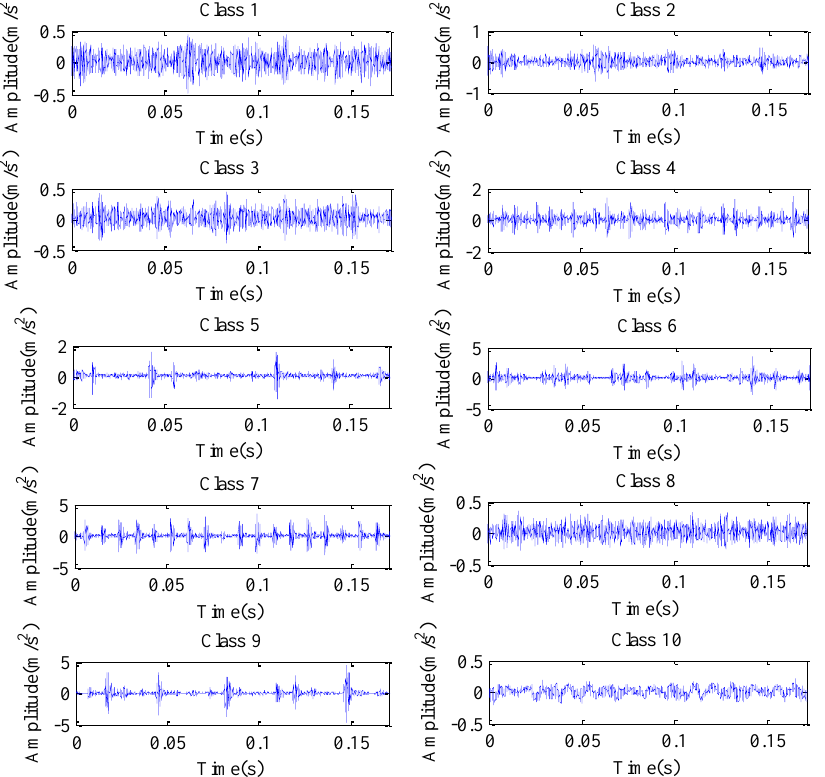
Figure 3. One vibration signal sample for each of the ten bearing fault classes.